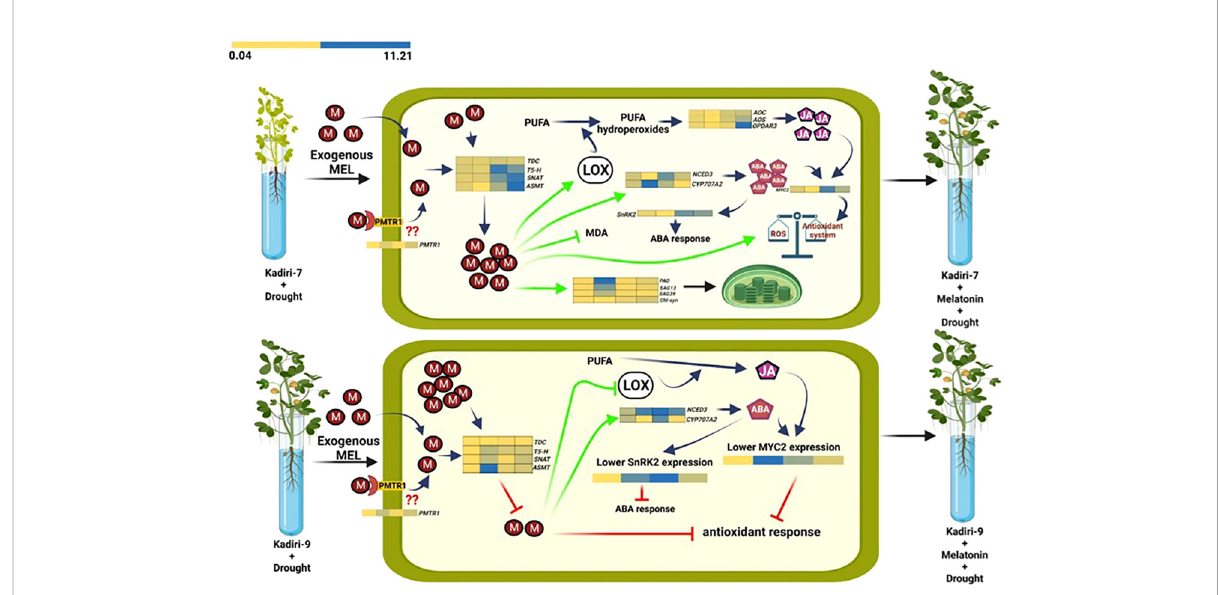
FIGURE 14 Differential effects of melatonin priming on drought-sensitive (Kadiri-7, upper) and drought-tolerant (Kadiri-9, lower) varieties of groundnut under drought stress to alleviate the impact of stress. Melatonin confers the tolerance in Kadiri-7 by improving endogenous melatonin content, antioxidant system and photosynthetic ef fi ciency. Additionally, melatonin-mediated amelioration of LOX expression and activity in turn increases the endogenous JA and ABA contents, which also provides stress tolerance. Furthermore, unprimed Kadiri-9 with higher endogenous melatonin correlates with its inherent tolerance nature. Contrarily, exogenous melatonin priming was found to decrease its endogenous level, possibly as a consequence of feedback inhibition to fi ne-tune melatonin biosynthesis and maintain redox homeostasis towards better plant metabolism under drought stress